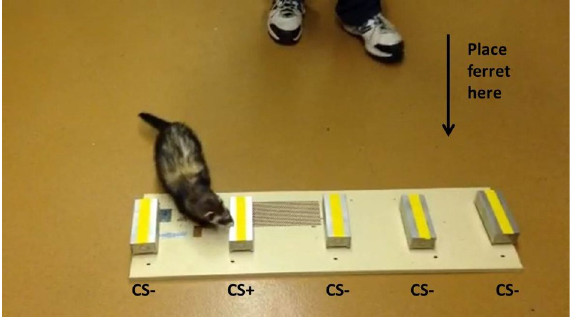
Fig 1. Apparatus to monitor operant-conditioned responses of trained ferrets to odors emitted from fecal samples derived from low pathogenic avian influenza (LPAI) infected and non-infected donor mallards. Aluminum “scratch” boxes were equipped with a sliding, self-locking cover and over 100 drilled holes (2-mm) in the cover and ends of the base compartment to allow for the escape of volatile odors. In the early stages of training, tape was used to modify the size of the drilled holes to prevent injury to the nails of the ferrets. The position numbers of the boxes were 1 through 5, left to right in all trials.